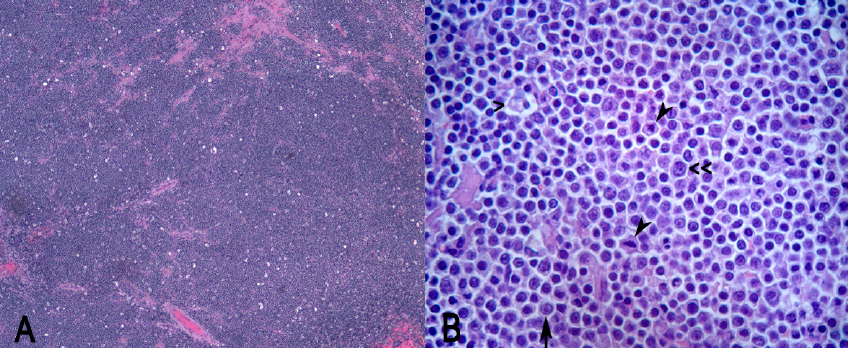
Figure 1. Gross findings. ( A ) Overall macroscopic features of abdominal and thoracic viscera at necropsy. ( B ) Spleen is expanded by white tan nodules, multifocal to coalescing. ( C ) Liver is increased in volume and is characterized by multiple raised white nodules. ( D ) Enlarged mesenteric lymph with a tan light-pinkish cut surface. Samples of the mesenteric lymph node, small and large intestine, spleen, liver, kidney, heart, and lung were processed for histopathology. A histopathological examination of tissue sections routinely stained with hematoxylin–eosin (HE) stain revealed monomorphic lymphomatous infiltration affecting the mesenteric lymph node, spleen, liver, kidneys, and heart. Few other microscopic changes were detected, including multiple foci of pneumoconiosis in the lung and bilateral, chronic, multifocal, and tubulointerstitial nephritis in the kidneys. Intestinal sections were diffusely autolytic. The mesenteric lymph node appeared effaced after being non-demarcated and unencapsulated, and densely cellular neoplasm composed by sheets of round cells were supported by scant fibrovascular stroma. Neoplastic cells were characterized by distinct cell borders, a high N/C ratio, and a scant amount of eosinophilic cytoplasm. Nuclei were 2× the size of red blood cells and were hyperchromatic with coarsely stippled chromatin. The nucleolar arrangement was variable; it was characterized by multiple peripherally located nucleoli (centroblast-like) or a single and central nucleolus (immunoblast-like) (Figure 2B). Anisocytosis and anisokariosis were moderate and mitosis was 22 in 2.37 mm 2 . Neoplastic cells were mixed with numerous tangible body macrophages which conferred a “starry-sky” microscopic appearance to the neoplasm (Figure 2A). Intratumorally areas of necrosis and hemorrhage, which were multifocal to coalescing, were detected.